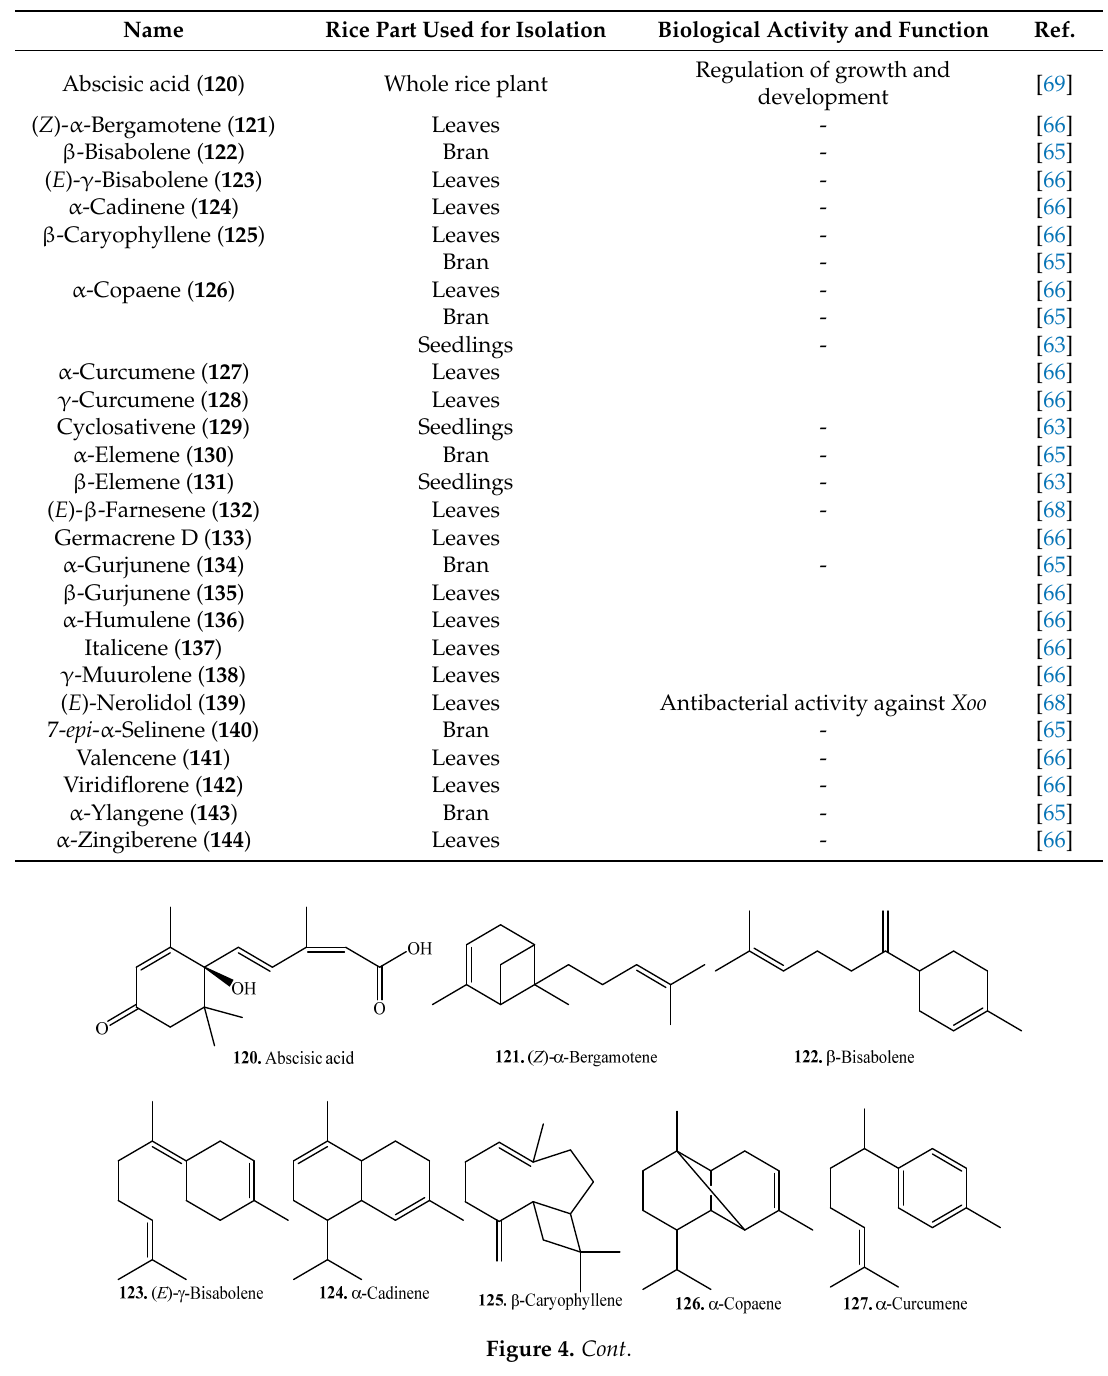
Table 4. Sesquiterpenoids and their biological activities and functions.